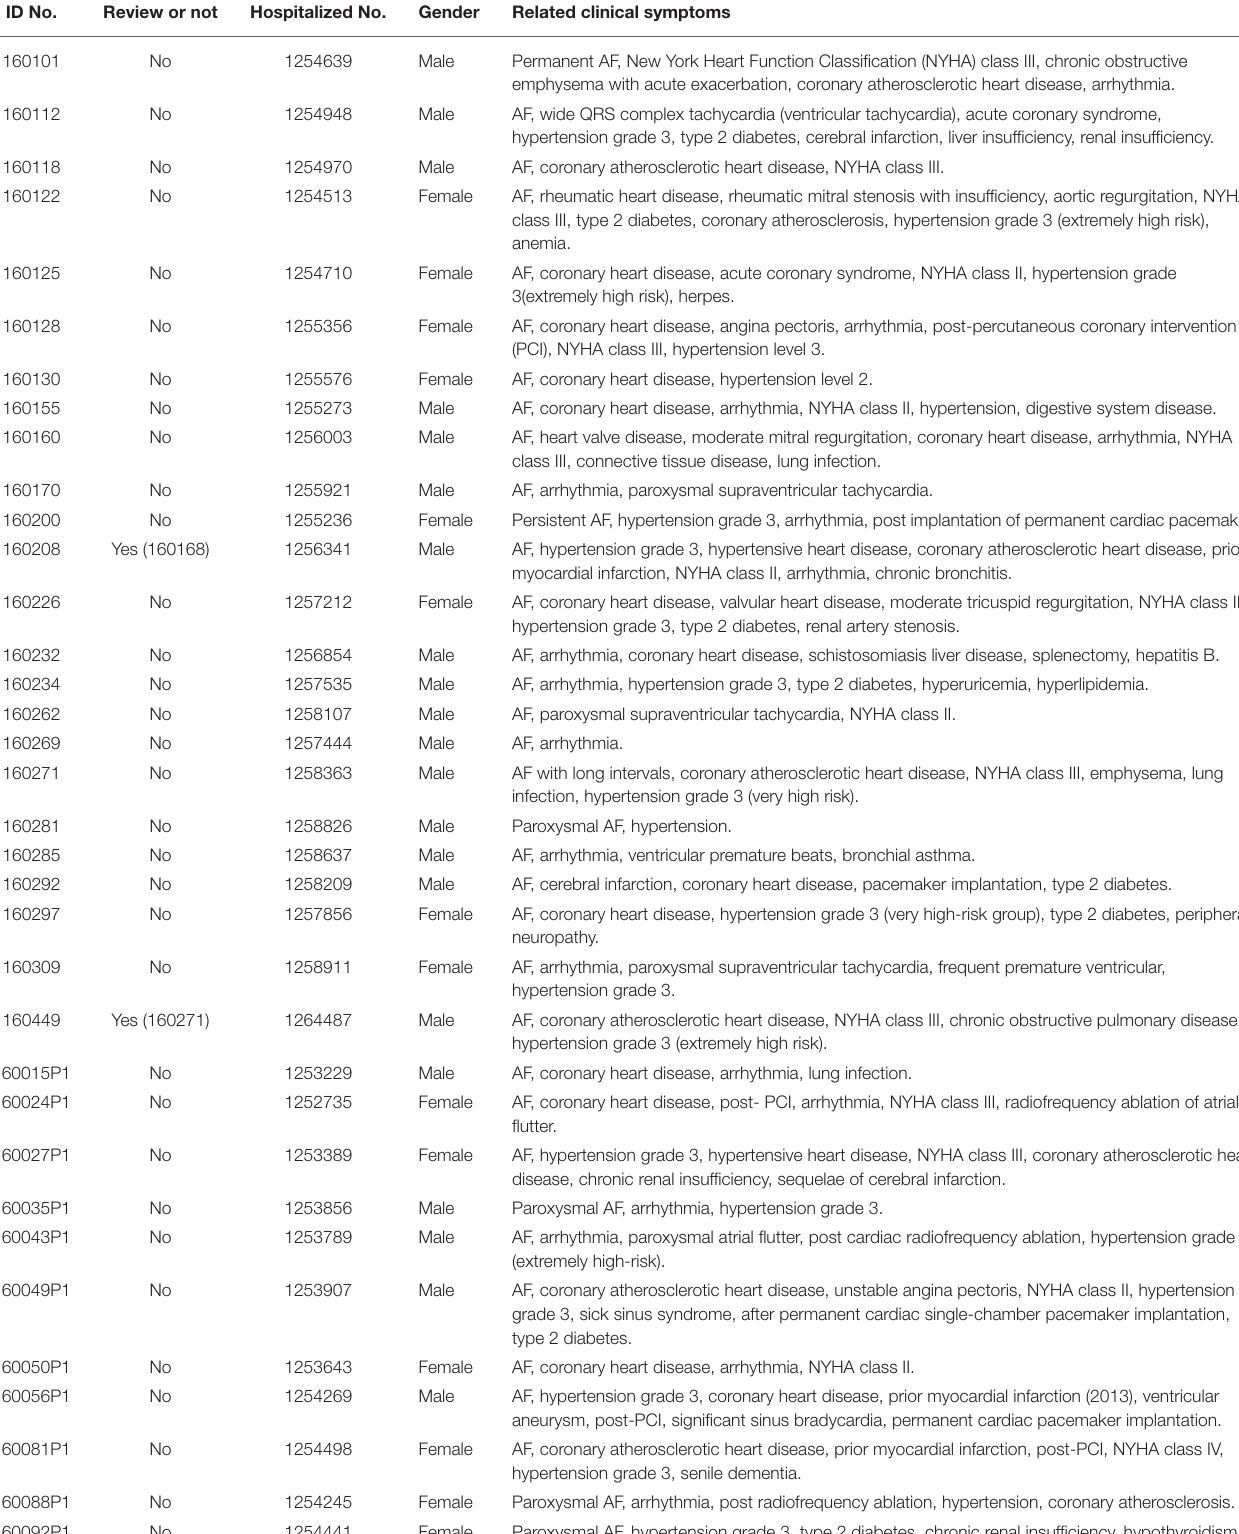
TABLE 1 | Clinical information of patients with AF. ID No. Review or